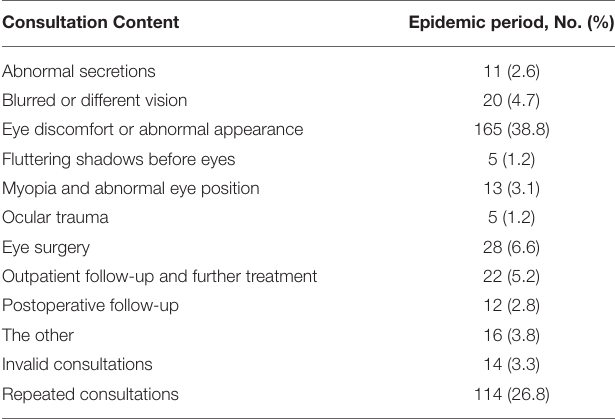
TABLE 1 | The content and proportion of online consultation. TABLE 2 | Socio-demographic variables of